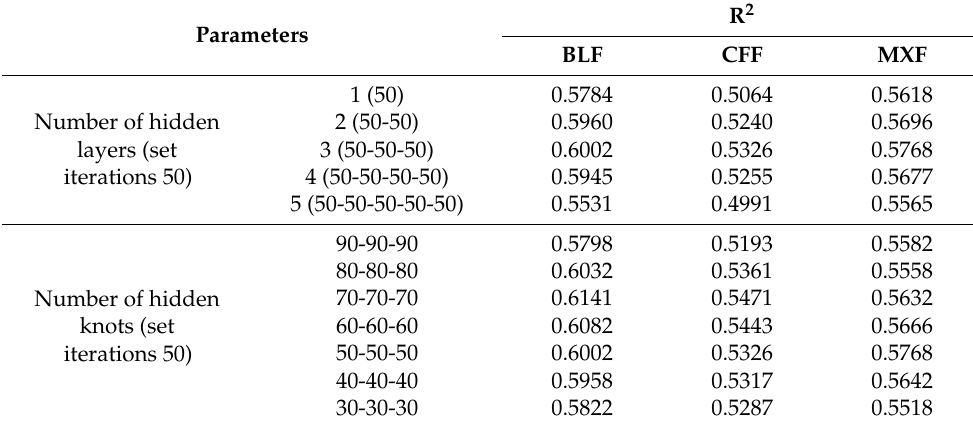
Table 4. Effect of parameter setting on the DBN model’s